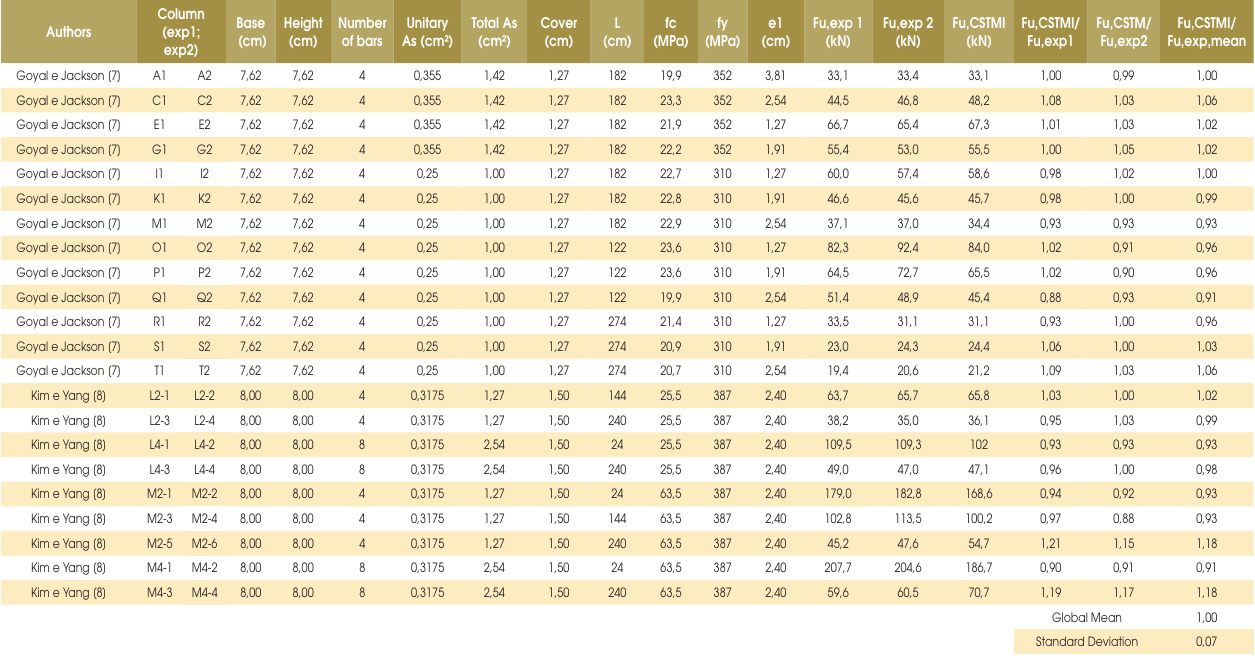
Table 1 – Comparison of resistance for reinforced concrete columns by tests and CSTMI